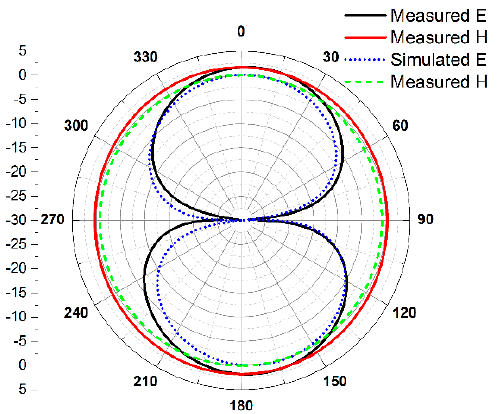
Figure 12. Measured and simulated radiation pattern for all switches OFF.